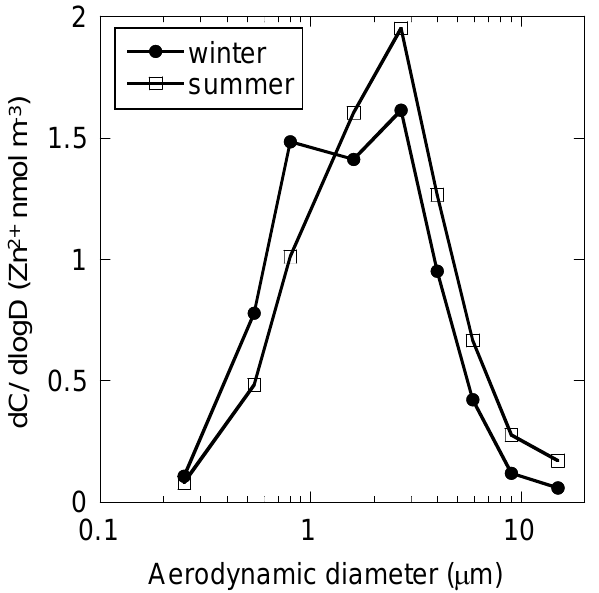
Fig. 3. Size distribution of Zn in aerosols during winter and summer at Tsukuba.